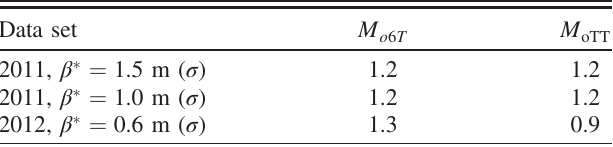
TABLE II. Margin IR6 – TCTs and TCT – triplet in units of σ